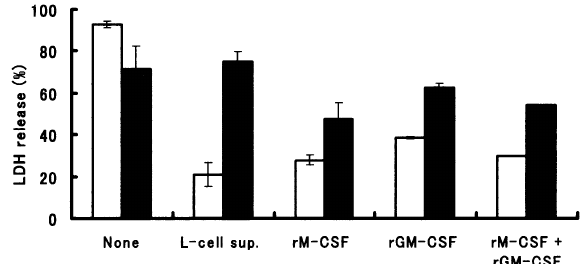
FIG. 4. Comparison of the cytolytic activity of securioside B against the BAC1.2F5 cells in the presence of L-cell-condi- tioned medium, M-CSF, and/or GM-CSF by LDH release assay. The BAC1.2F5 cells were cultured with 10 m g/ml securioside B in the presence of L-cell-conditioned medium (20%), 100 ng/ml rM-CSF, 100 ng/ml rGM-CSF, or a mixture of rM-CSF and rGM-CSF (100 ng/ml of each) for 3 days. LDH release from the cells was described in Materials and methods. Bars represent the standard deviation.